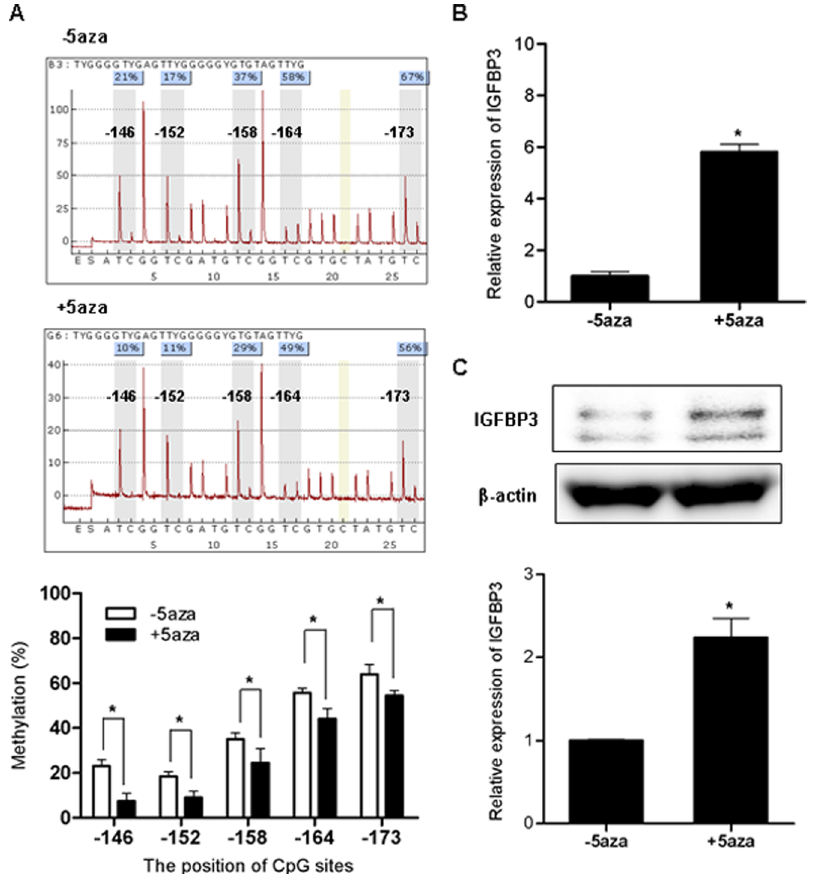
Figure 4. IGFBP3 expression changes following demethylation in APP-Swedish mutant cells H4-sw cells were treated for 3 days with 10 m M 5-aza-2 9 -deoxycytidine. DNA methylation status at specific CpG sites were analyzed using bisulfite pyrosequence analyses. The average percent methylation of triplicate pyrosequencing analyses from each of the five CpG sites are presented graphically (A). After treatment with 5-aza- dC, IGFBP3 mRNA expression was measured using qPCR (B). IGFBP3 protein expression was detected using western blot analyses. Representative results are illustrated and values from densitometric analyses after normalization to b -actin are reported relative to that of untreated controls (C). Data are shown as the mean 6 SD (n=3). Statistical analyses were performed using t -tests (* indicates p , 0.05). 5aza, 5-aza-2 9 -deoxycytidine.